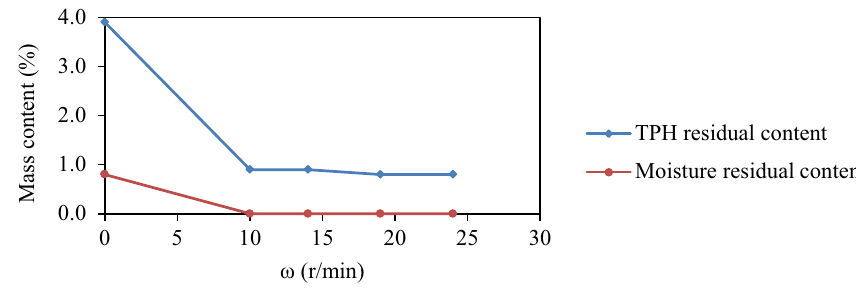
Fig. 6 Residual content of TPH and moisture in solid slag at dif- ferent stirring speed (the termi- nal temperature of 350 °C and the residence time of 30